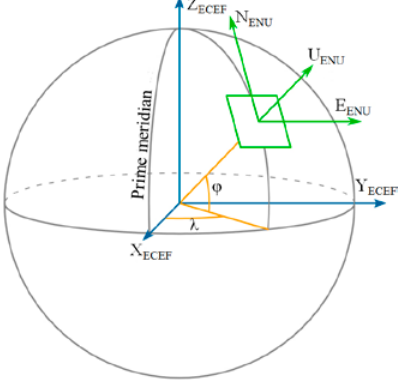
Fig. 6. Comparison of the ECEF and ENU coordinate systems (Cai